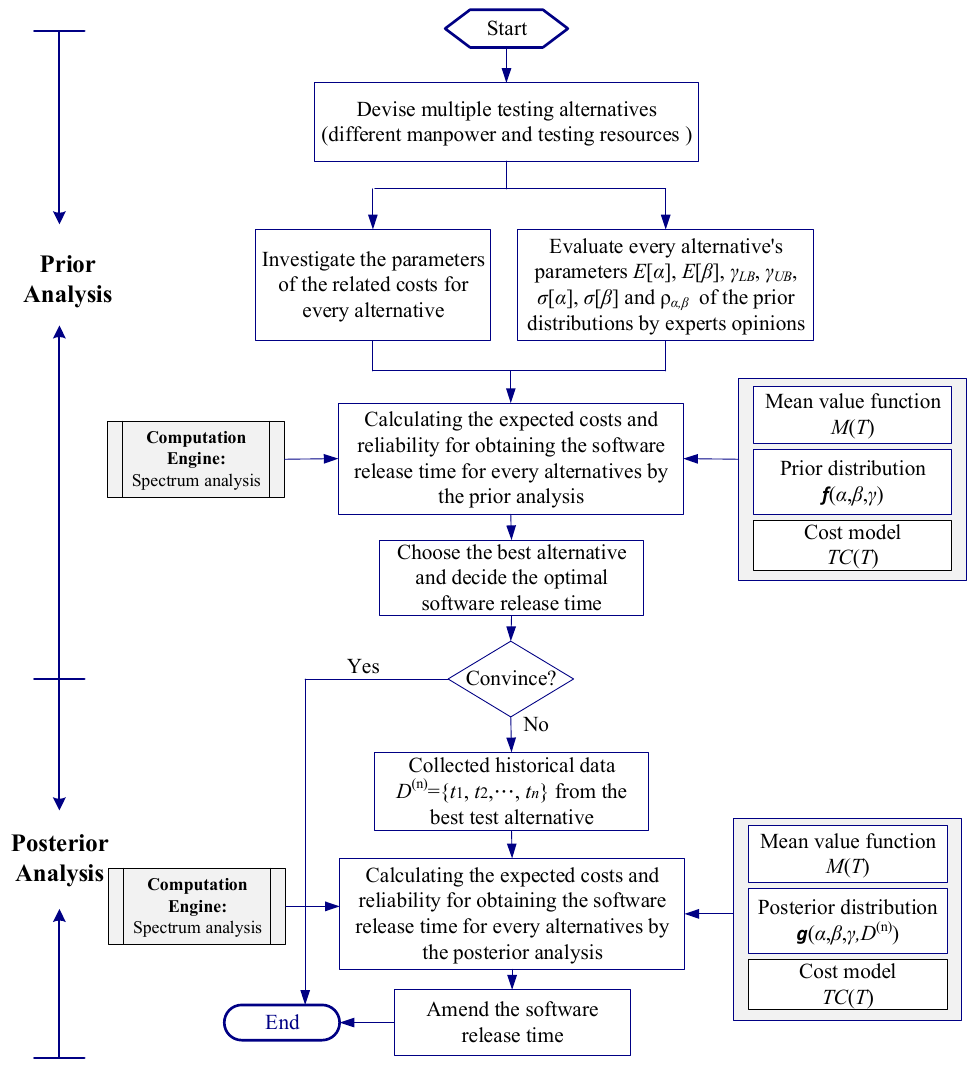
Figure 7. Decision process for the Bayesian analysis.